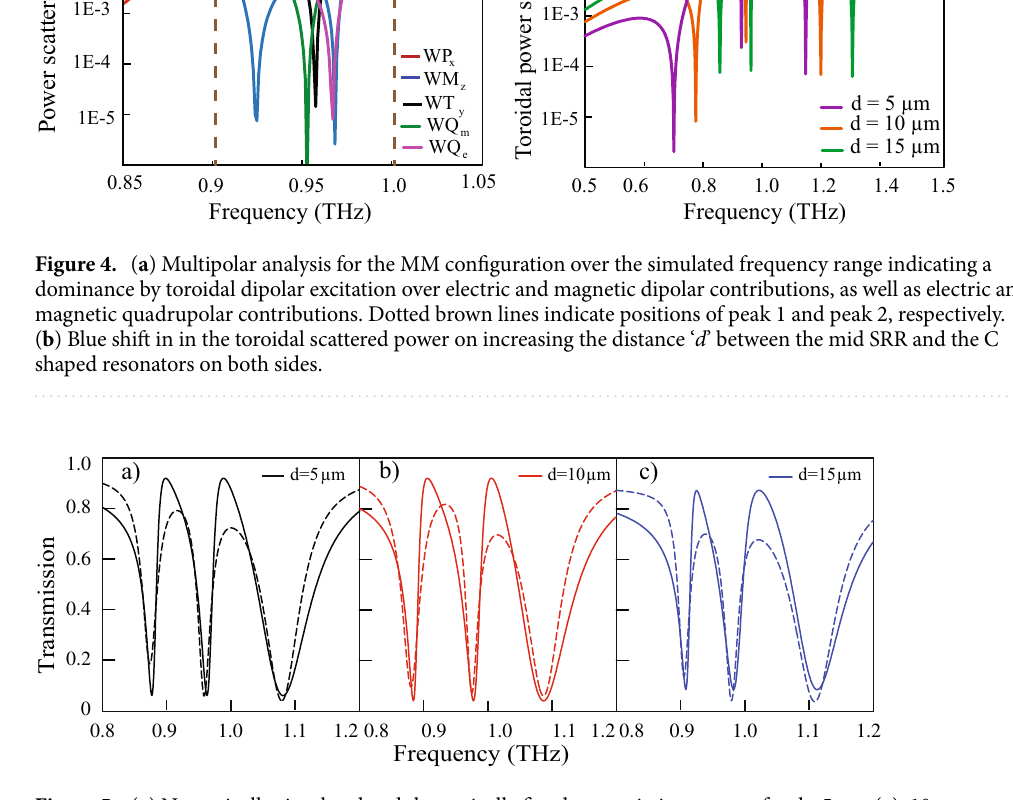
Figure 5. ( a ) Numerically simulated and theoretically fitted transmission spectra for d= 5 µ m ( a ), 10 µ m ( b ) and 15 µ m ( c ). The dotted lines indicate the transmission profile obtained by theoretical modeling for the proposed multiband EIT